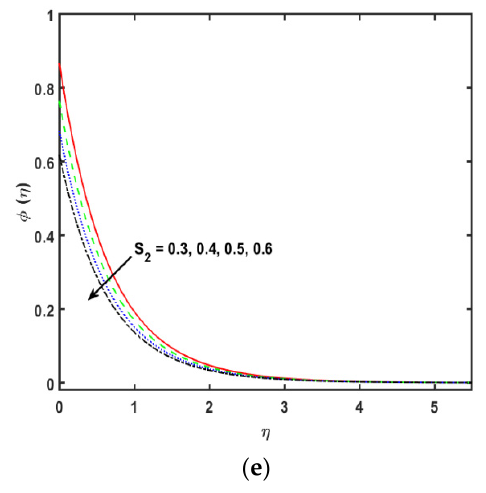
Figure 5. ( a – e ): Variation in S c , β c , K 1 , τ and S 2 , respectively. Table 1. Numerical variations of skin friction coefficient against some parameters at 𝑆 (cid:2869) = 0.1 , 𝑆 (cid:2870) = 0.4 , 𝜀 = 0.3 , 𝛽 (cid:3030) = 0.7 and 𝛿 = 0.5 .